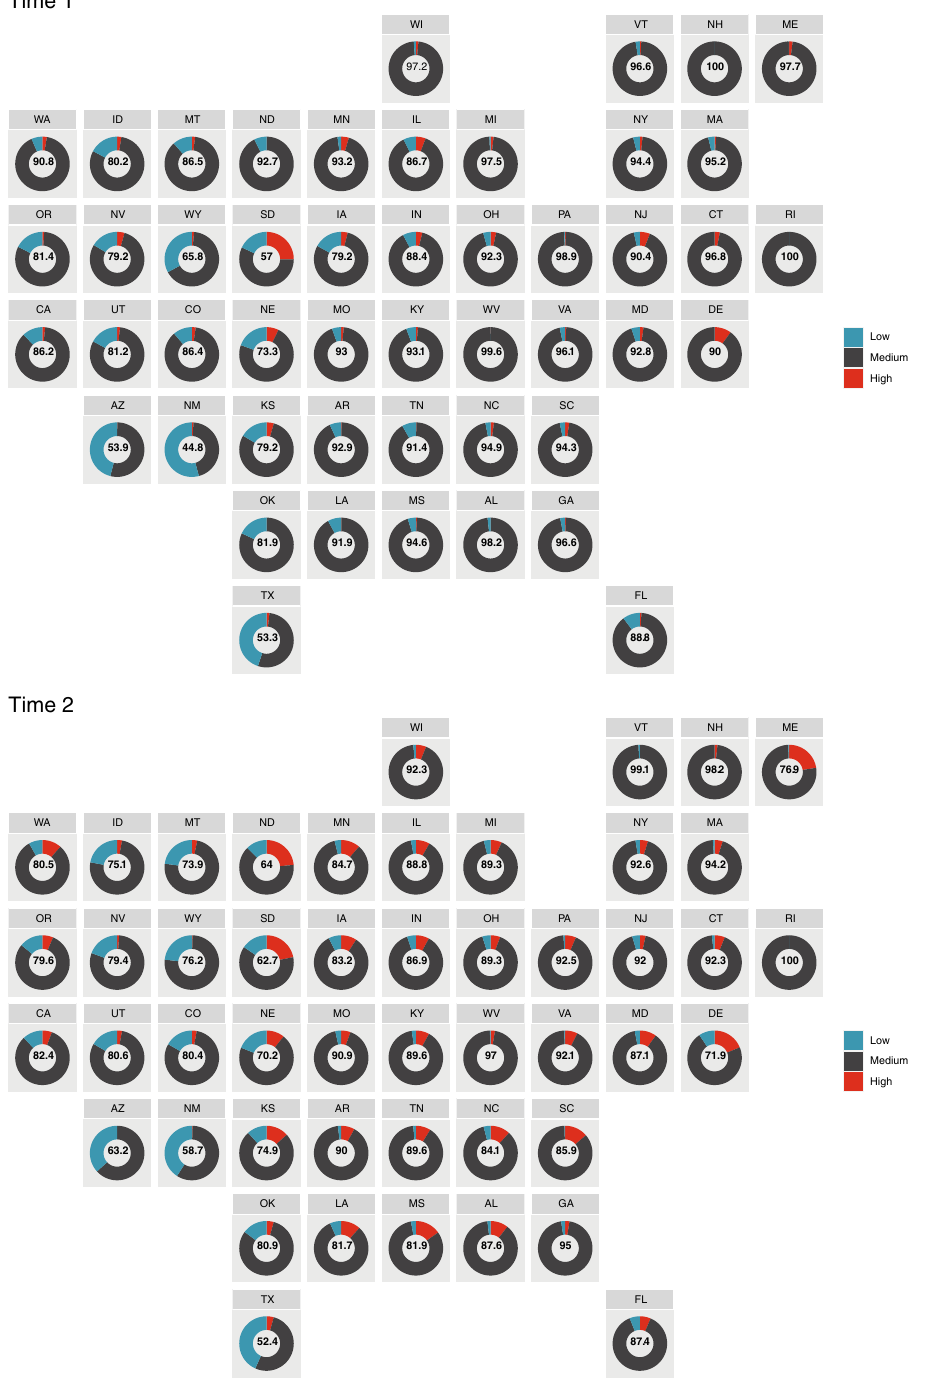
Figure 3. Proportion of forest area by stocking class and state for Time 1 (1999–2012) and Time 2 (2013–2020), with percentage of total forest area by state in fully stocked conditions (0.3 ≥ RD < 0.6) provided in the middle of each state doughnut. Facetted map produced in R v3.6.3 52